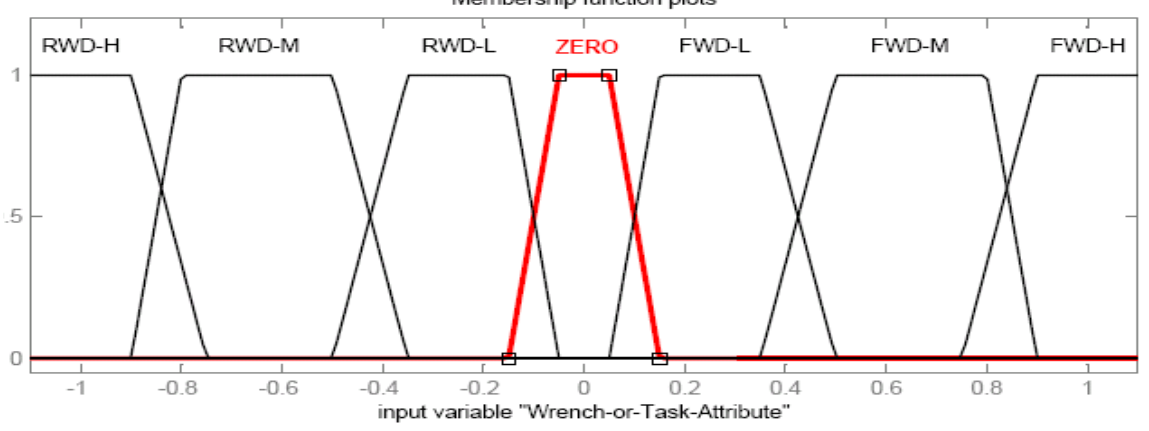
Figure 8. Fuzzy Membership Functions for Grasp Wrench or Tasks.